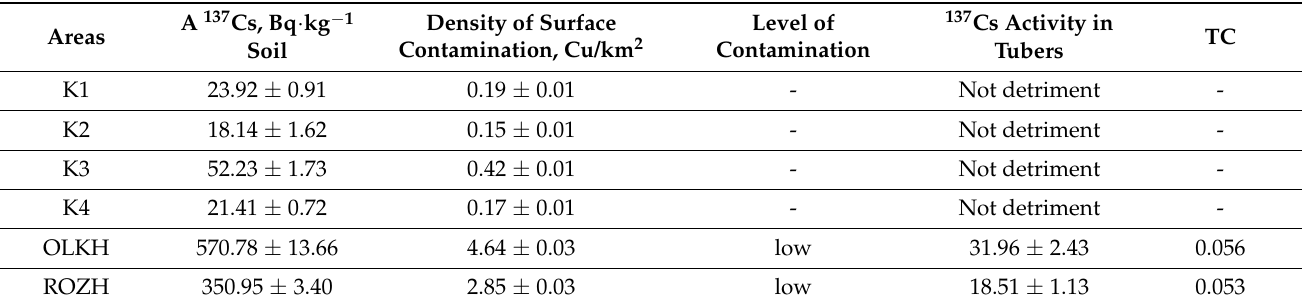
Table 3. 137 Cs content in soil and H. tuberosus plants.